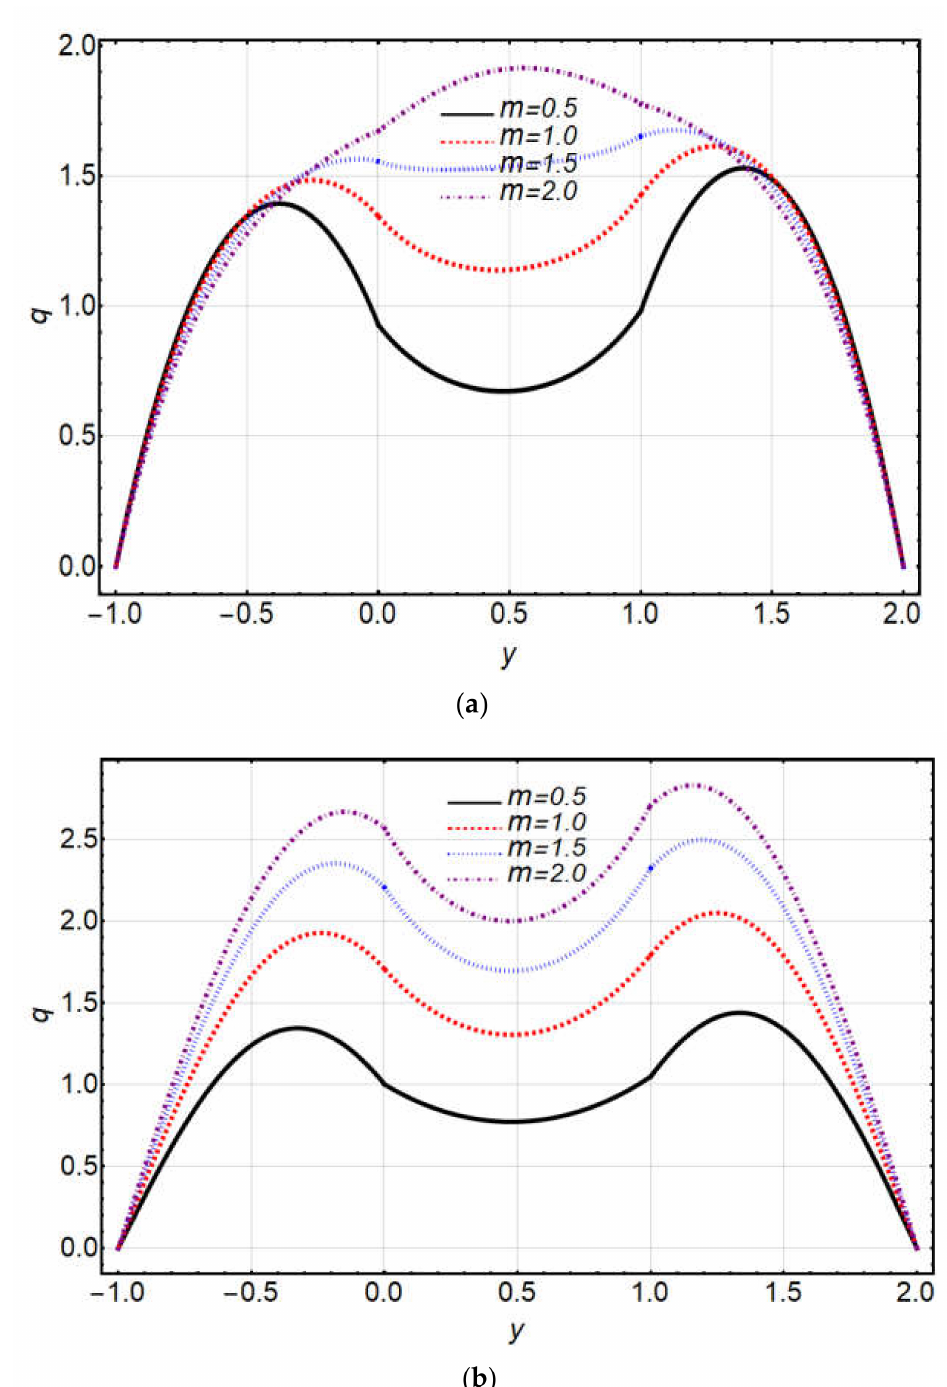
Figure 4. Velocity distribution of m : ( a ) axial, ( b )